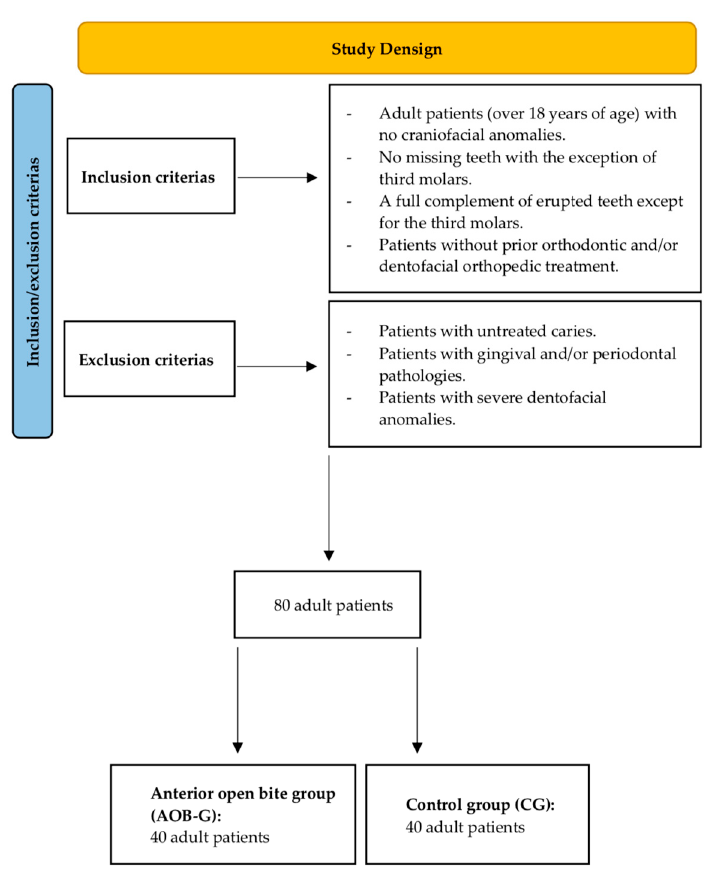
Figure 1. Flow chart with the study design.